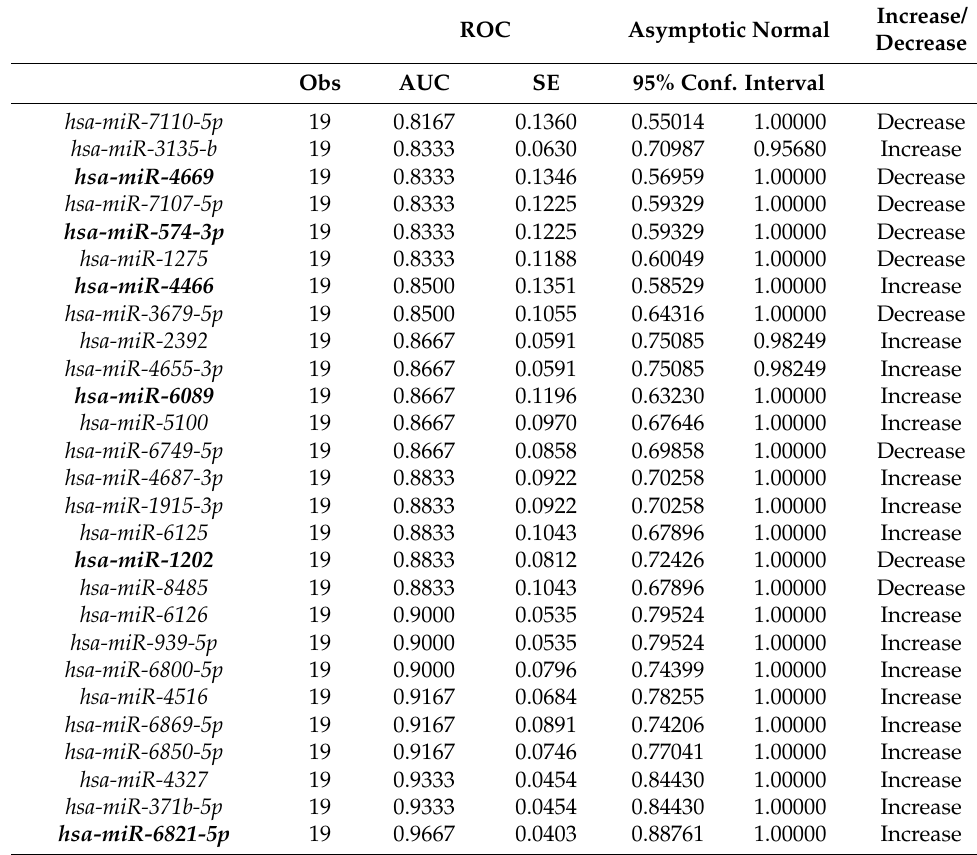
Table 2. Serum miRNAs and early PDAC diagnosis. miRNAs showing an area under the ROC curve (AUC) higher than that of CA 19-9 in distinguishing controls from PDAC are reported. SE: standard error; 95% CI: 95% confidence interval; Increase/Decrease: miRNA levels increased or decreased in PDAC with respect to controls. Bold face: miRNAs significantly correlated with PDAC diagnosis at binary logistic regression analysis. Increase/ ROC Asymptotic Normal Decrease